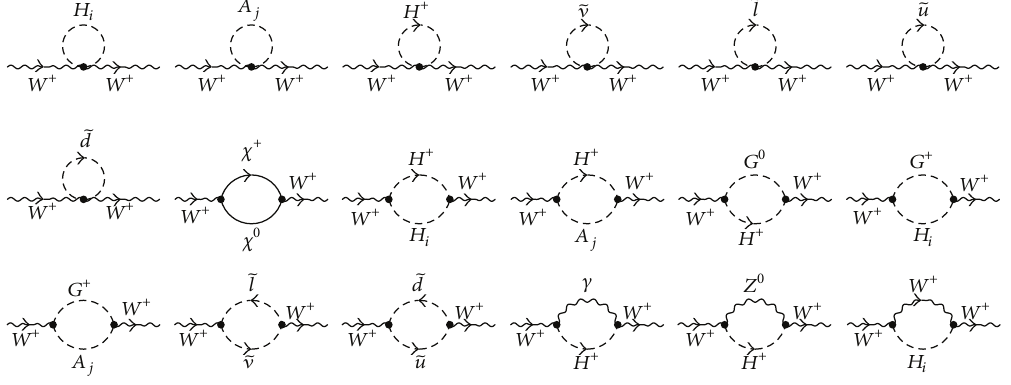
Figure 4: Feynman diagram contribution to the self-energy Π NMSSM 𝑊𝑊 (𝑠) .